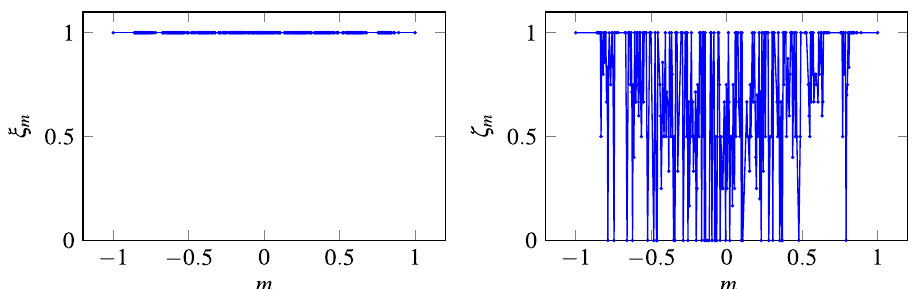
Figure 4. Consensus efficacy ξ m and classification efficacy ζ m of the evolution of a set of initial configurations characterized by a magnetization m considering the Von Newmann vicinity, from which at each step only one neighbor is chosen and the majority rule applied. This result was obtained for a grid of N = 441 nodes with asynchronous iterations. The reader may note that even if all configurations reach consensus ( ξ m = 1 ), this approach has poor quality regarding its classification metric, i.e. ζ m = 1 for all instances.